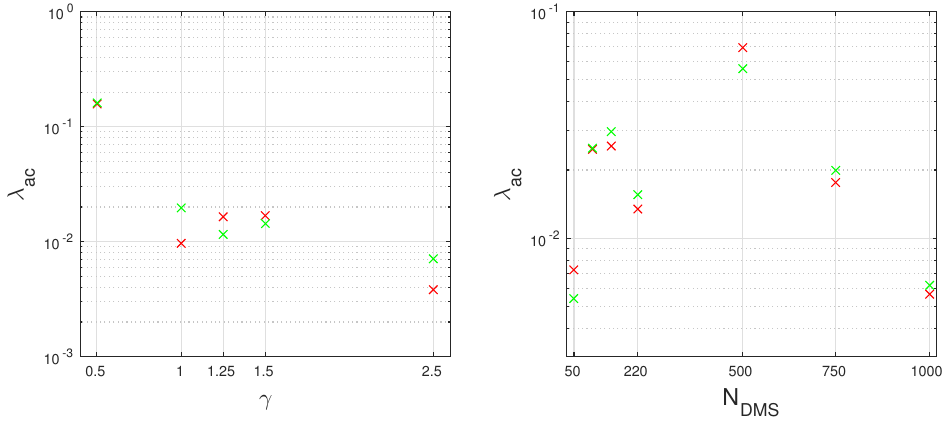
Figure 11. Values of λ ac at µ = 1 for horizontal planes (red) and vertical planes